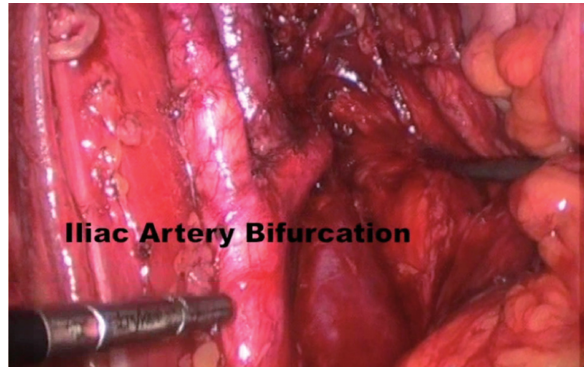
Figure 2 - Major vessels after